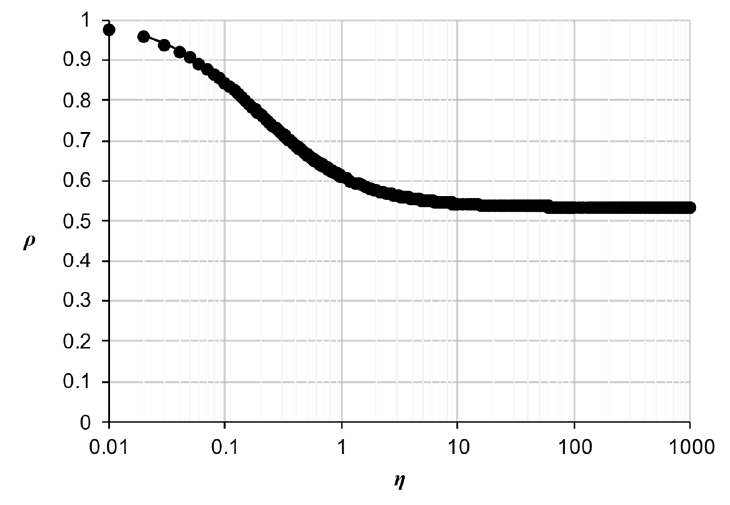
Figure 8. Dependence of ρ (ratio between the cost of a traditional explicit integration and the cost of the precomputation–interpolation strategy) on the value of η (relative importance of the computation of the plastic steps over the elastic steps).